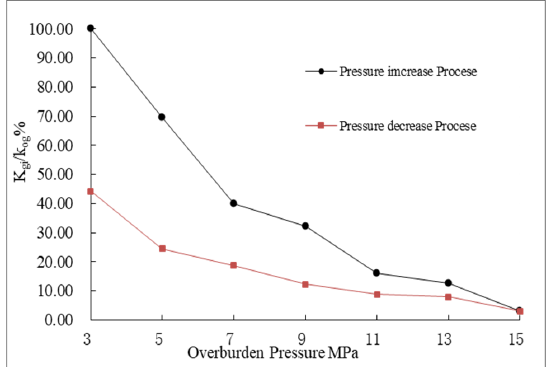
Figure 14. Typical core stress compression curve.